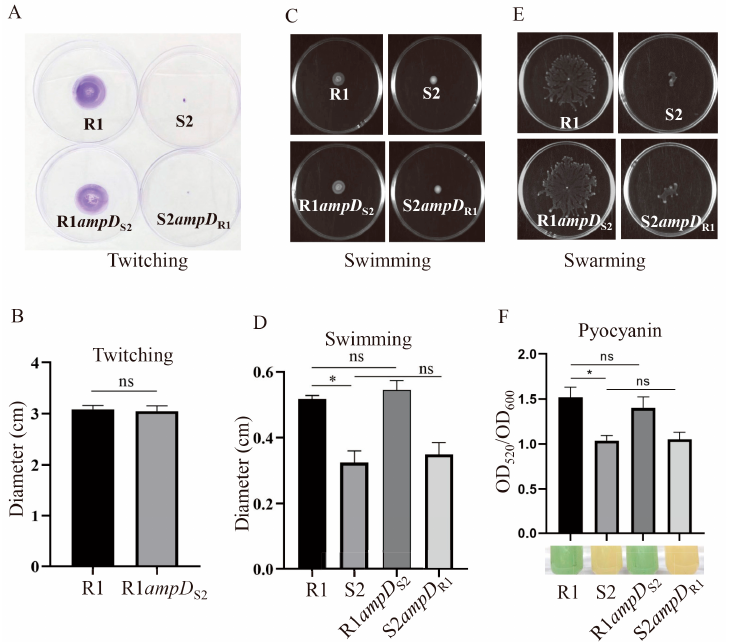
Figure 4. Motility and pyocyanin production were reduced in the S2 strain compared to the R1 strain. Twitching motility on plate ( A ) or diameters of the twitching zone ( B ) for indicated strains. Swimming motility on plate ( C ) or diameters of the swimming zone ( D ) for indicated strains. Swarming motility of the indicated strains on plates ( E ). Pyocyanin production in the indicated strains ( F ). Data presented here represent the means of three samples ± standard deviations. ns, not significant; *, p < 0.05, by Student’s t test.